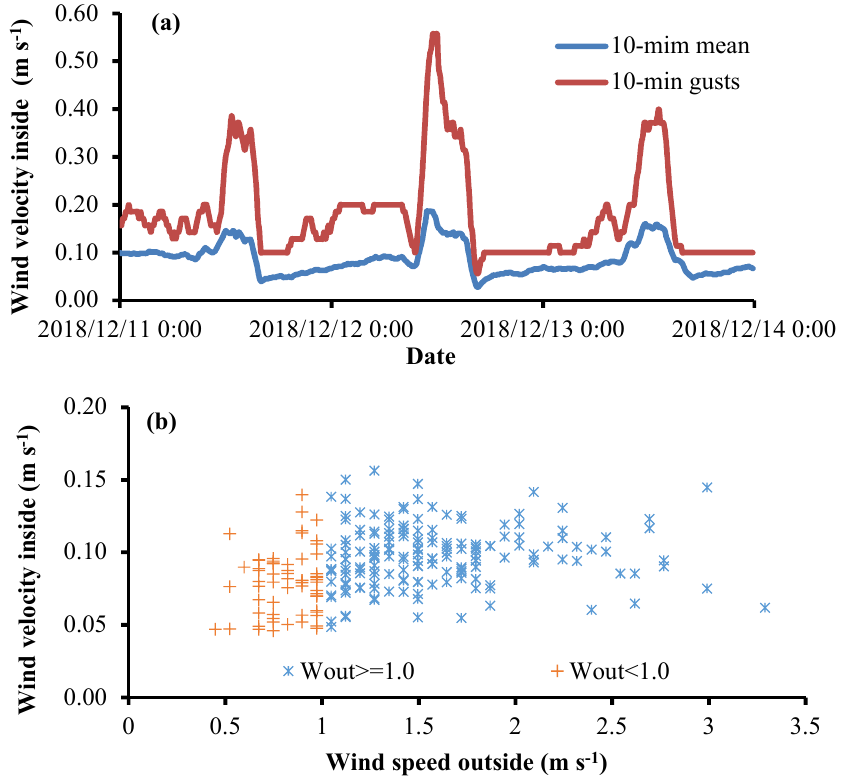
Figure 7. Mean and gust of wind velocity inside the greenhouse ( a ) and relationship between wind speeds inside and outside ( b ). Symbols of the brown cross ( + ) and blue star (*) on figure ( b ) indicate outside wind speed (Wout) being lower and higher than 1.0 m s − 1 , respectively.